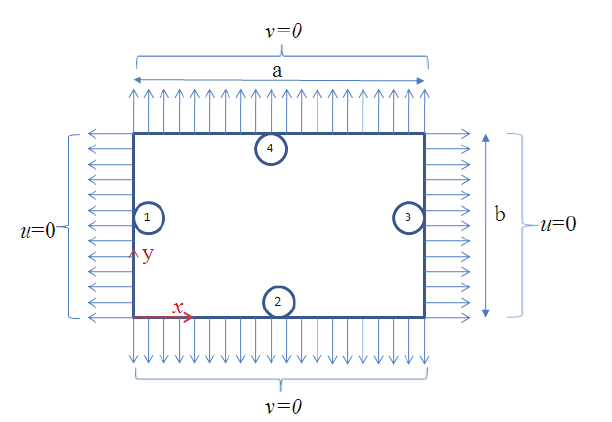
Figure 1. A rectangular plate subjected to in-plane forces (In-plane displacements are constrained to move as shown in this